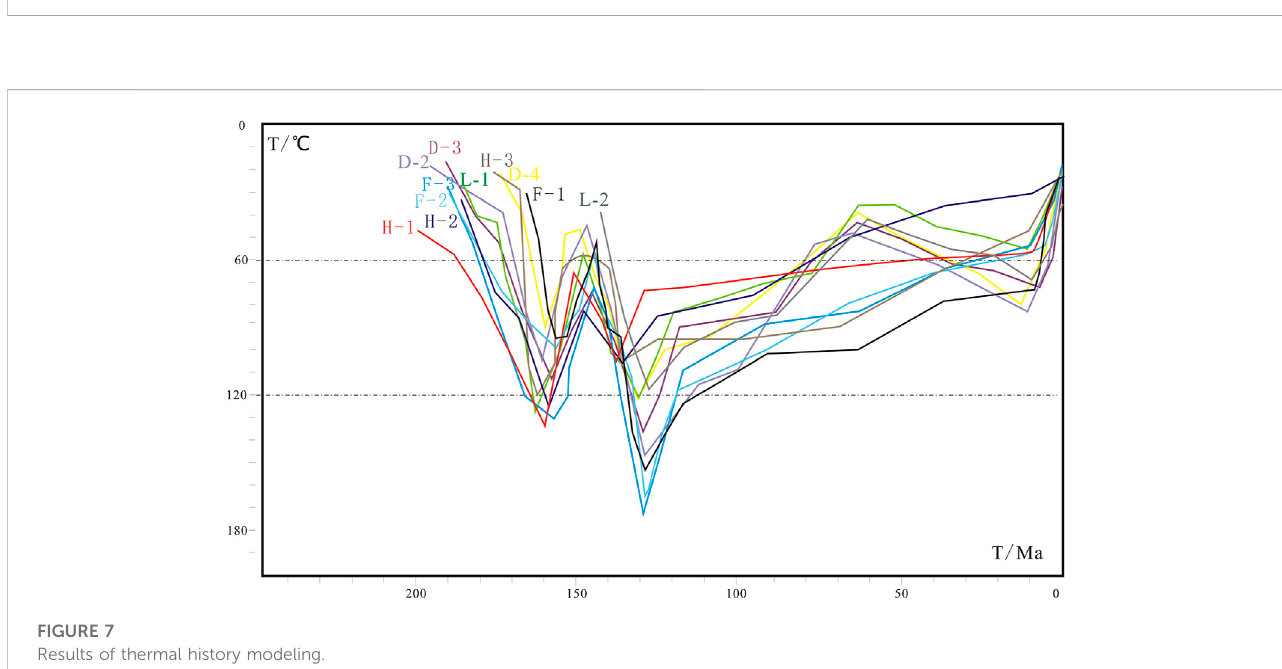
FIGURE 7 Results of thermal history